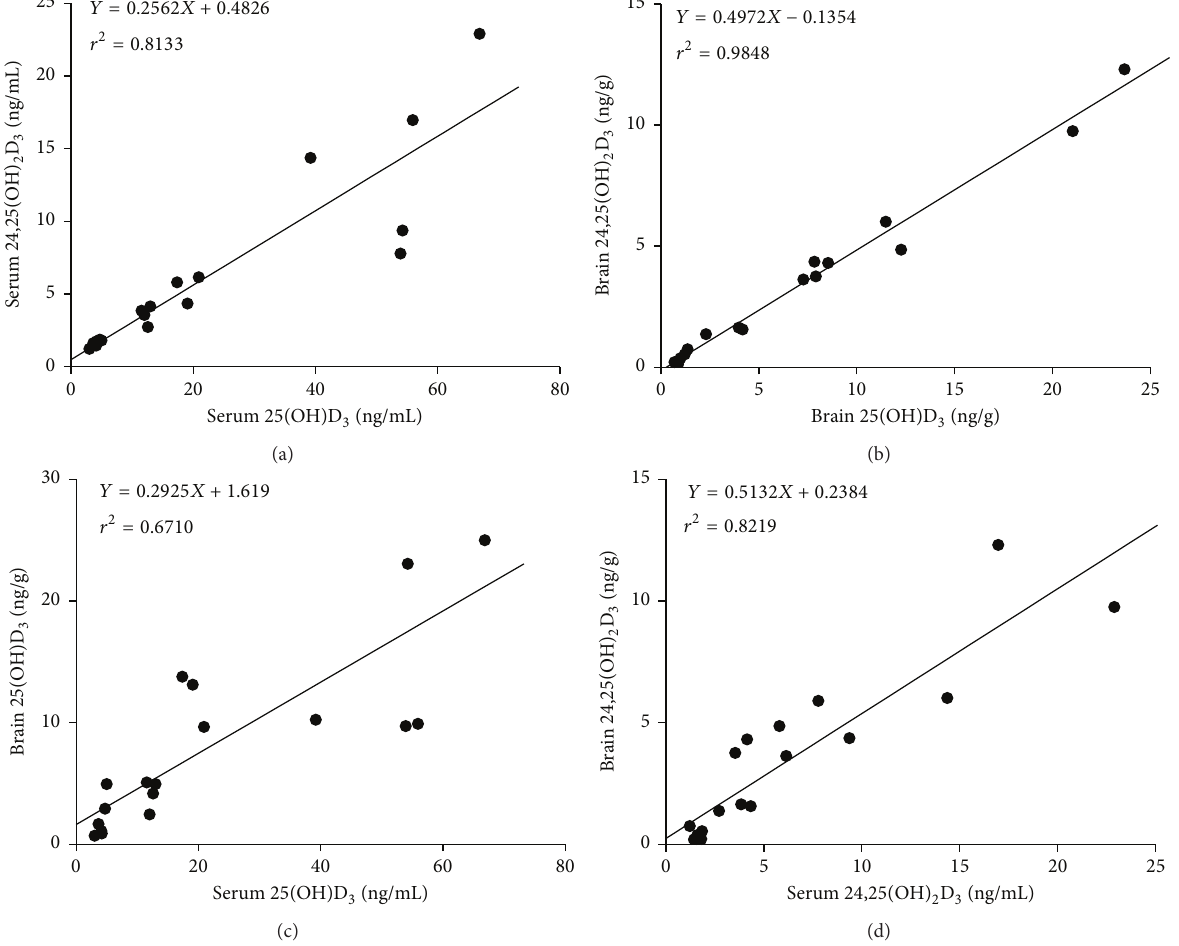
Figure 5: Correlation between serum 25(OH)D 3 and serum 24,25(OH) 2 D 3 (a), brain 25(OH)D 3 and brain 24,25(OH) 2 D 3 (b), serum 25(OH)D 3 and brain 25(OH)D 3 (c), and serum 24,25(OH) 2 D 3 and brain 24,25(OH) 2 D 3